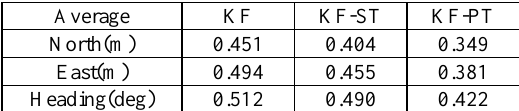
Table 1. Average Absolute Position and Heading Errors